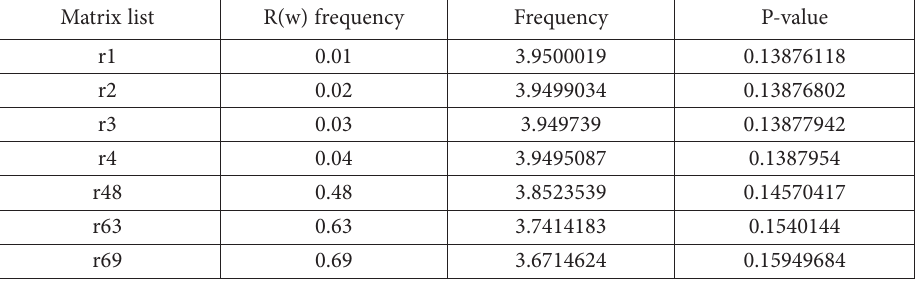
Table 2. Spectral Granger causality test results (business cycles impact financial cycles) (source: authors’ calculation)